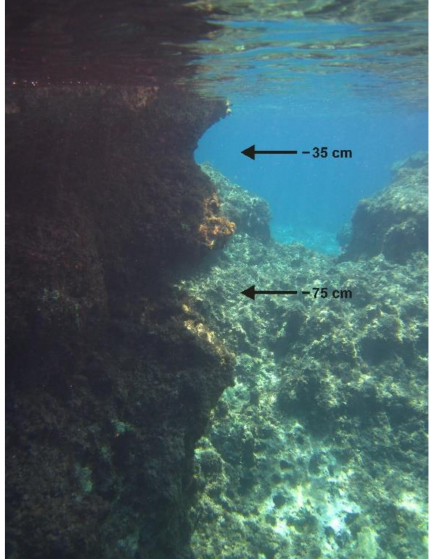
Figure 2. Submerged notch of type c’ at Naxos Island. Table 3. Number, amount and rough estimation of the possible return times of the late Holocene coseismic subsidence disclosed from submerged tidal notches at the islands of Naxos, Keros, Iraklia,